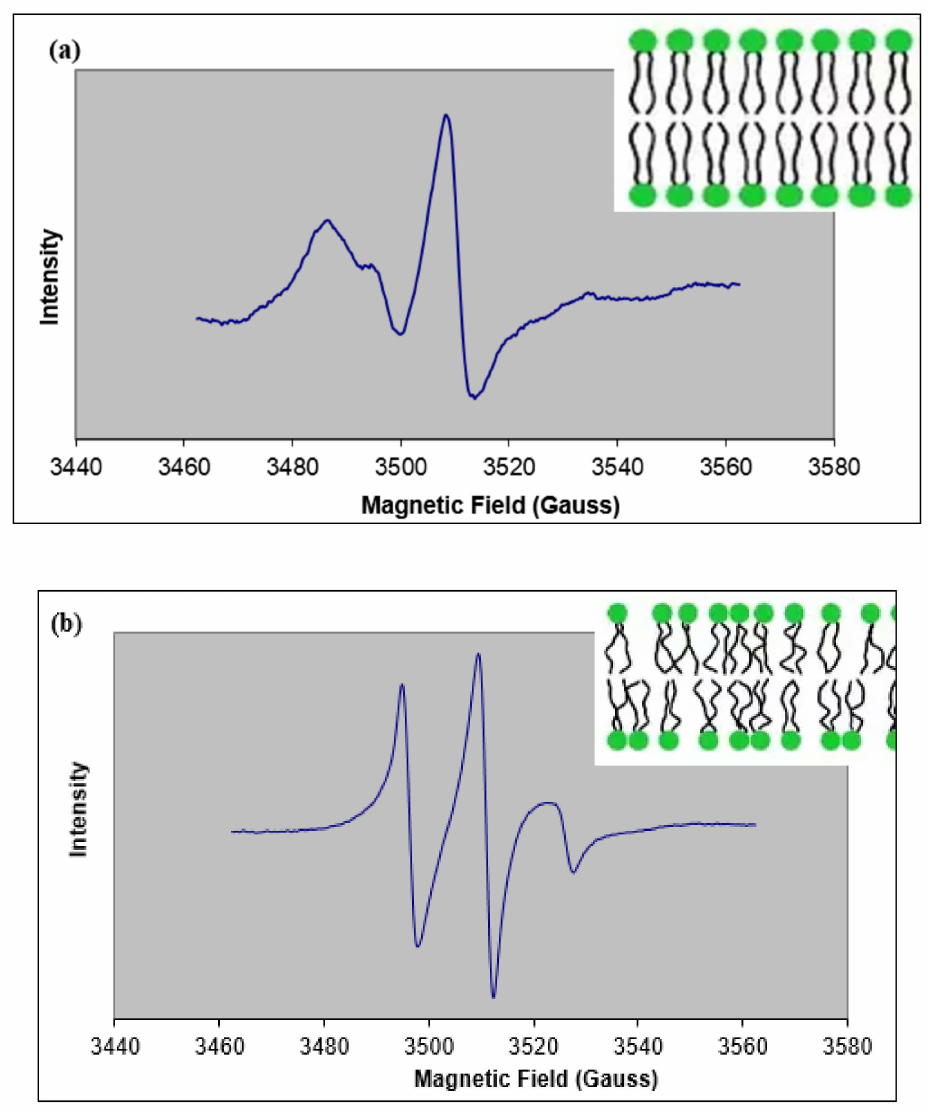
Figure 5. Example ESR spectra from 16-DSA. ( a ) ESR spectrum for 16-DSA incorporated into control buccal prototype liposomes measured at room temperature. Broad spectral lines represent rigid membrane as depicted in the insert. ( b ) ESR spectrum for 16-DSA incorporated into liposomes exposed to 5% sodium caprylate and 1% l-menthol measured at room temperature. Narrow spectral lines indicate a fluidized membrane as depicted in the